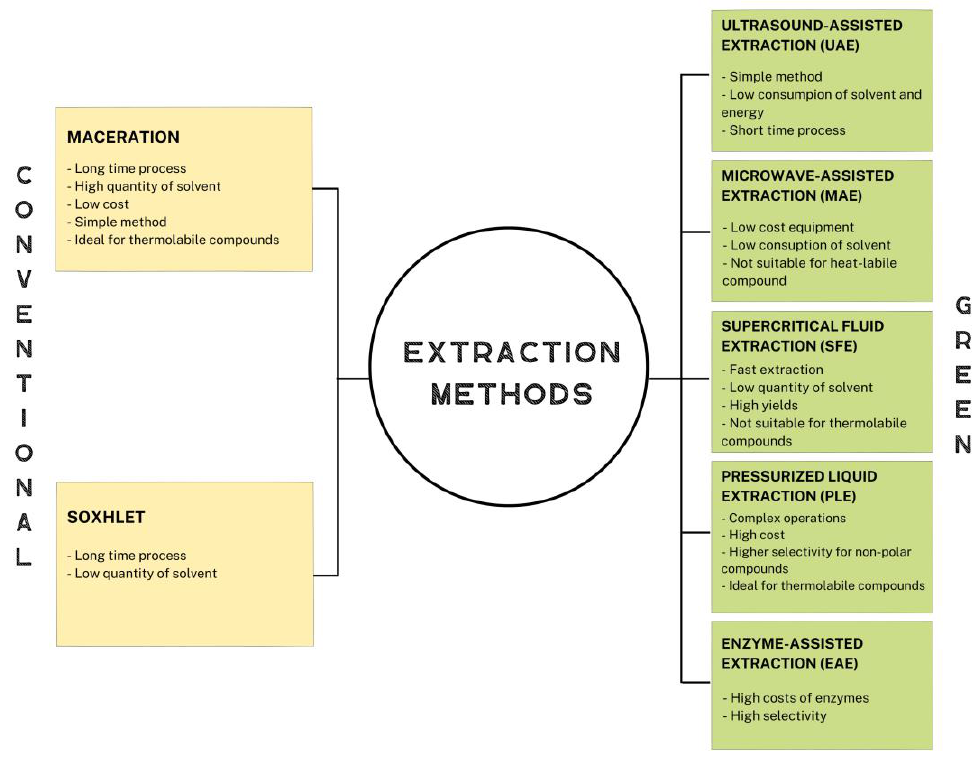
Figure 1. Advantages and limitations of conventional and green extraction methods.